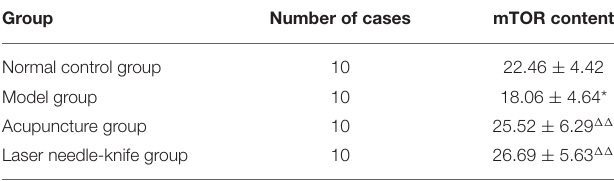
needle knife groups compared to the model group (both p <